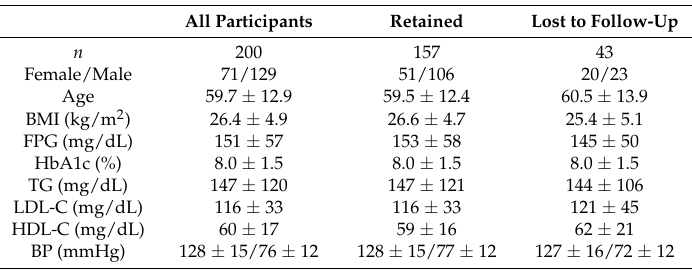
Table 1. Baseline characteristics of the study participants